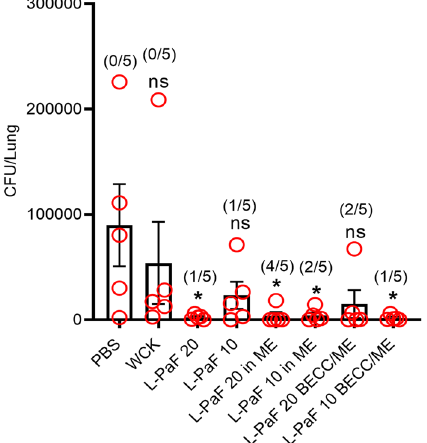
Fig. 4 The in vivo protective ef fi cacy of each vaccine formulation was determined. Mice were challenged with 1 × 10 8 CFU/30 µl/ mouse of mPa08-31 and lung burden was determined after 16 h post infection (HPI) ( n = 5). The points represent individual CFU/lung values, and the SDs are denoted by error bars. Lung burden was compared between PBS and all the other groups using a Dunnett ’ s test. * p <